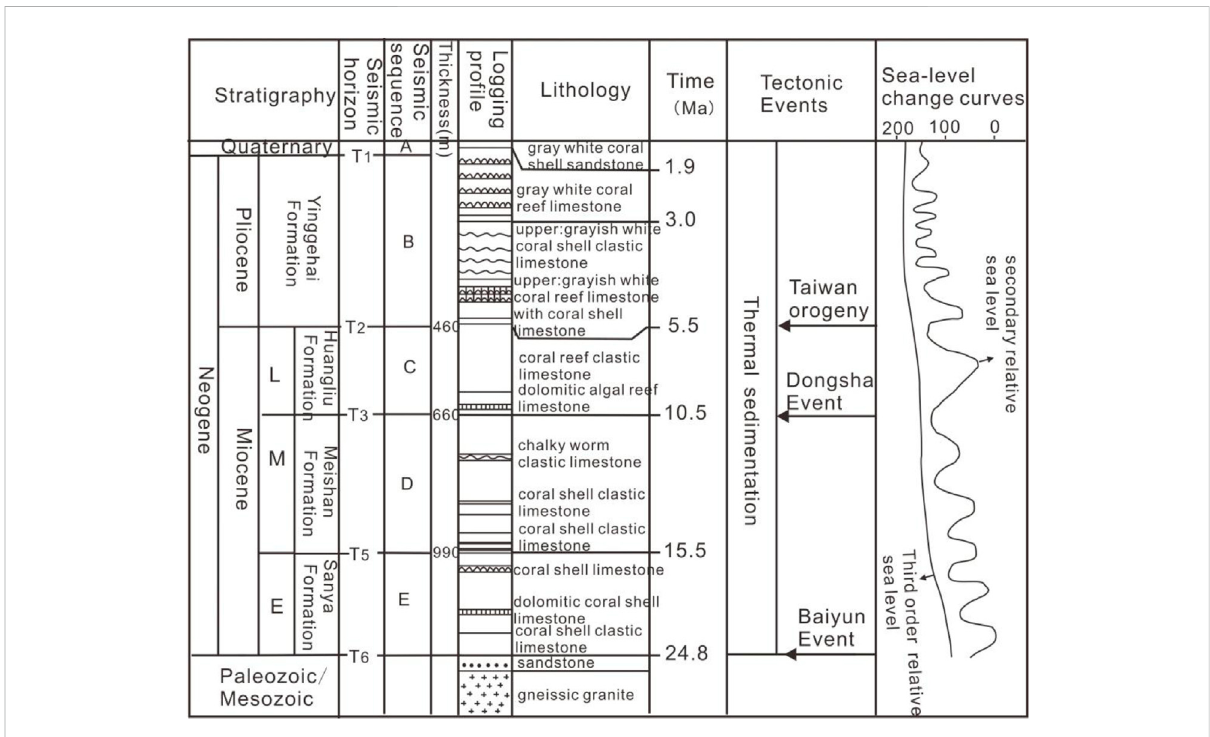
FIGURE 2 The stratigraphic column of XY1 well in the Xisha Sea area (Modi fi ed from Ma et al.